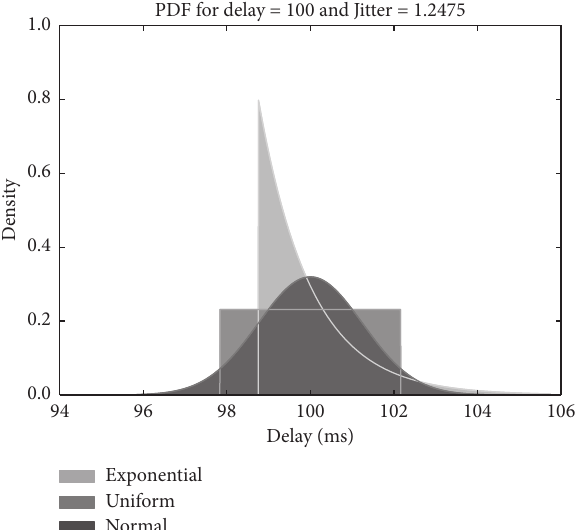
Figure 2: PDF for three different distributions.